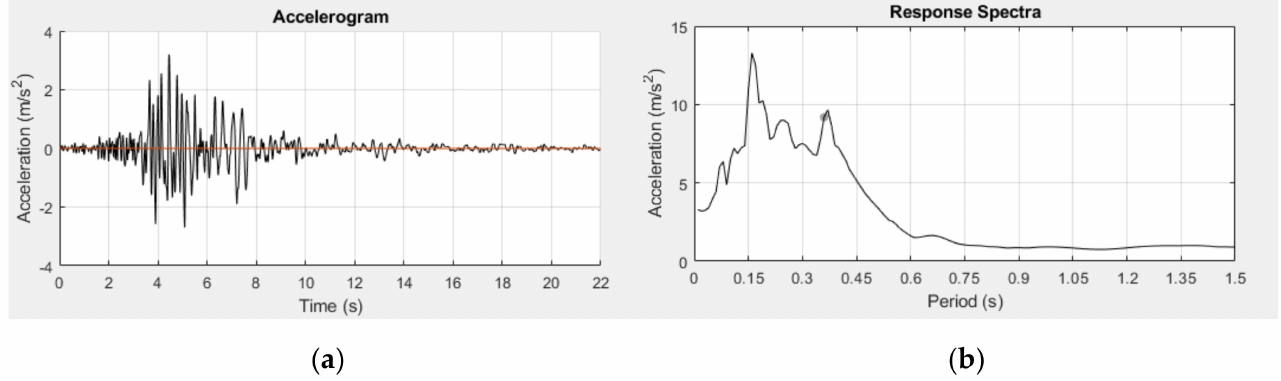
Figure 3. Seismic input n. 1 (F a = 1.5): ( a ) time history; ( b ) response